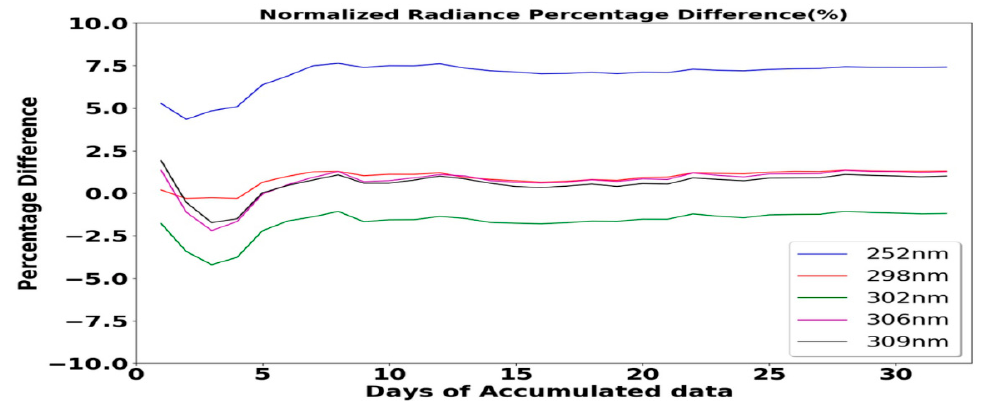
Figure 19. Time series of the globally-averaged brightness temperature differences at five OMPS NP channels between SNPP and NOAA-20, which are calculated using the datasets from one to 32 days with a two-sigma threshold applied to the data.